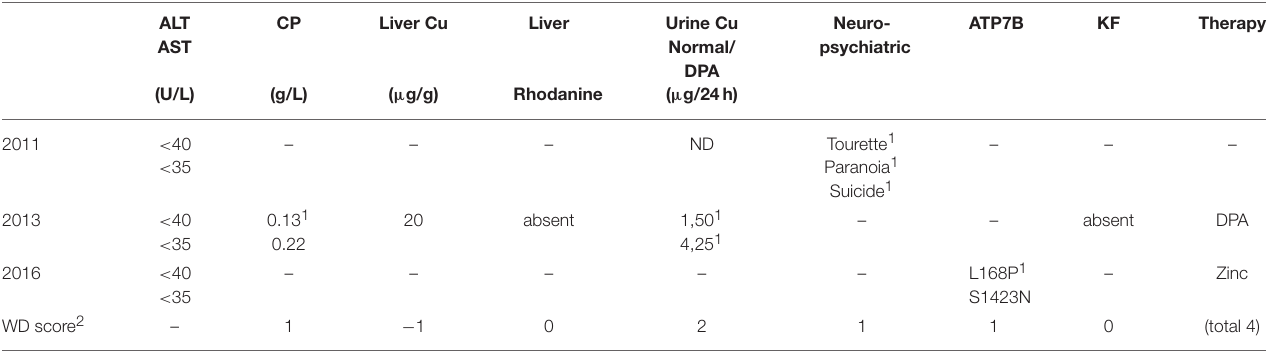
TABLE 1 | Patient